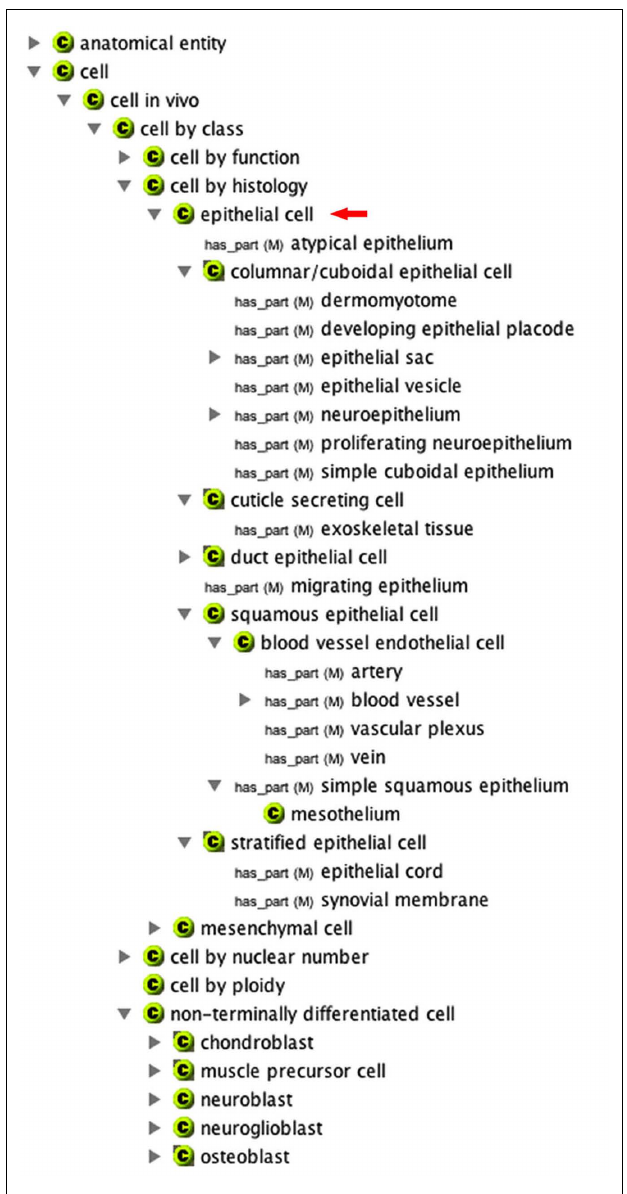
FIGURE 5 |The cell-type hierarchy of theAEO shown in the COBrA browser. This subset of the full cell-type ontology includes about 90 classes in all but only the epithelial cell class is expanded (red arrow).The editor uses the has_part relationship to show those anatomical entities (simple-tissues) which include the various epithelial